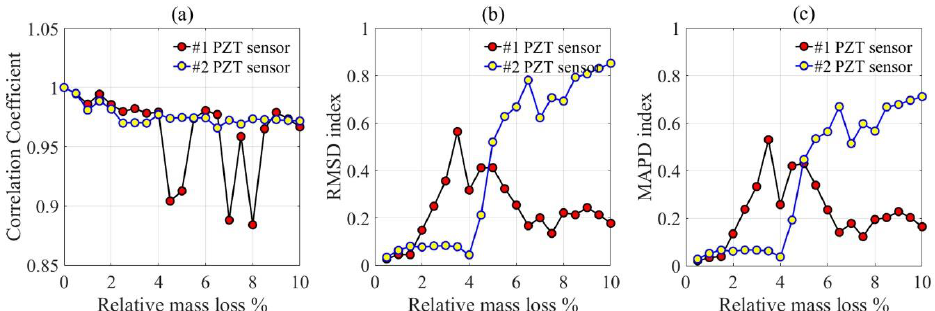
Figure 8. Corrosion indices of PZT transducers in a frequency interval of 25–75 kHz. ( a ) Correlation Coefficient; ( b ) RMSD index; ( c ) MAPD index. RMSD: root mean square deviation; MAPD: mean absolute percentage deviation.